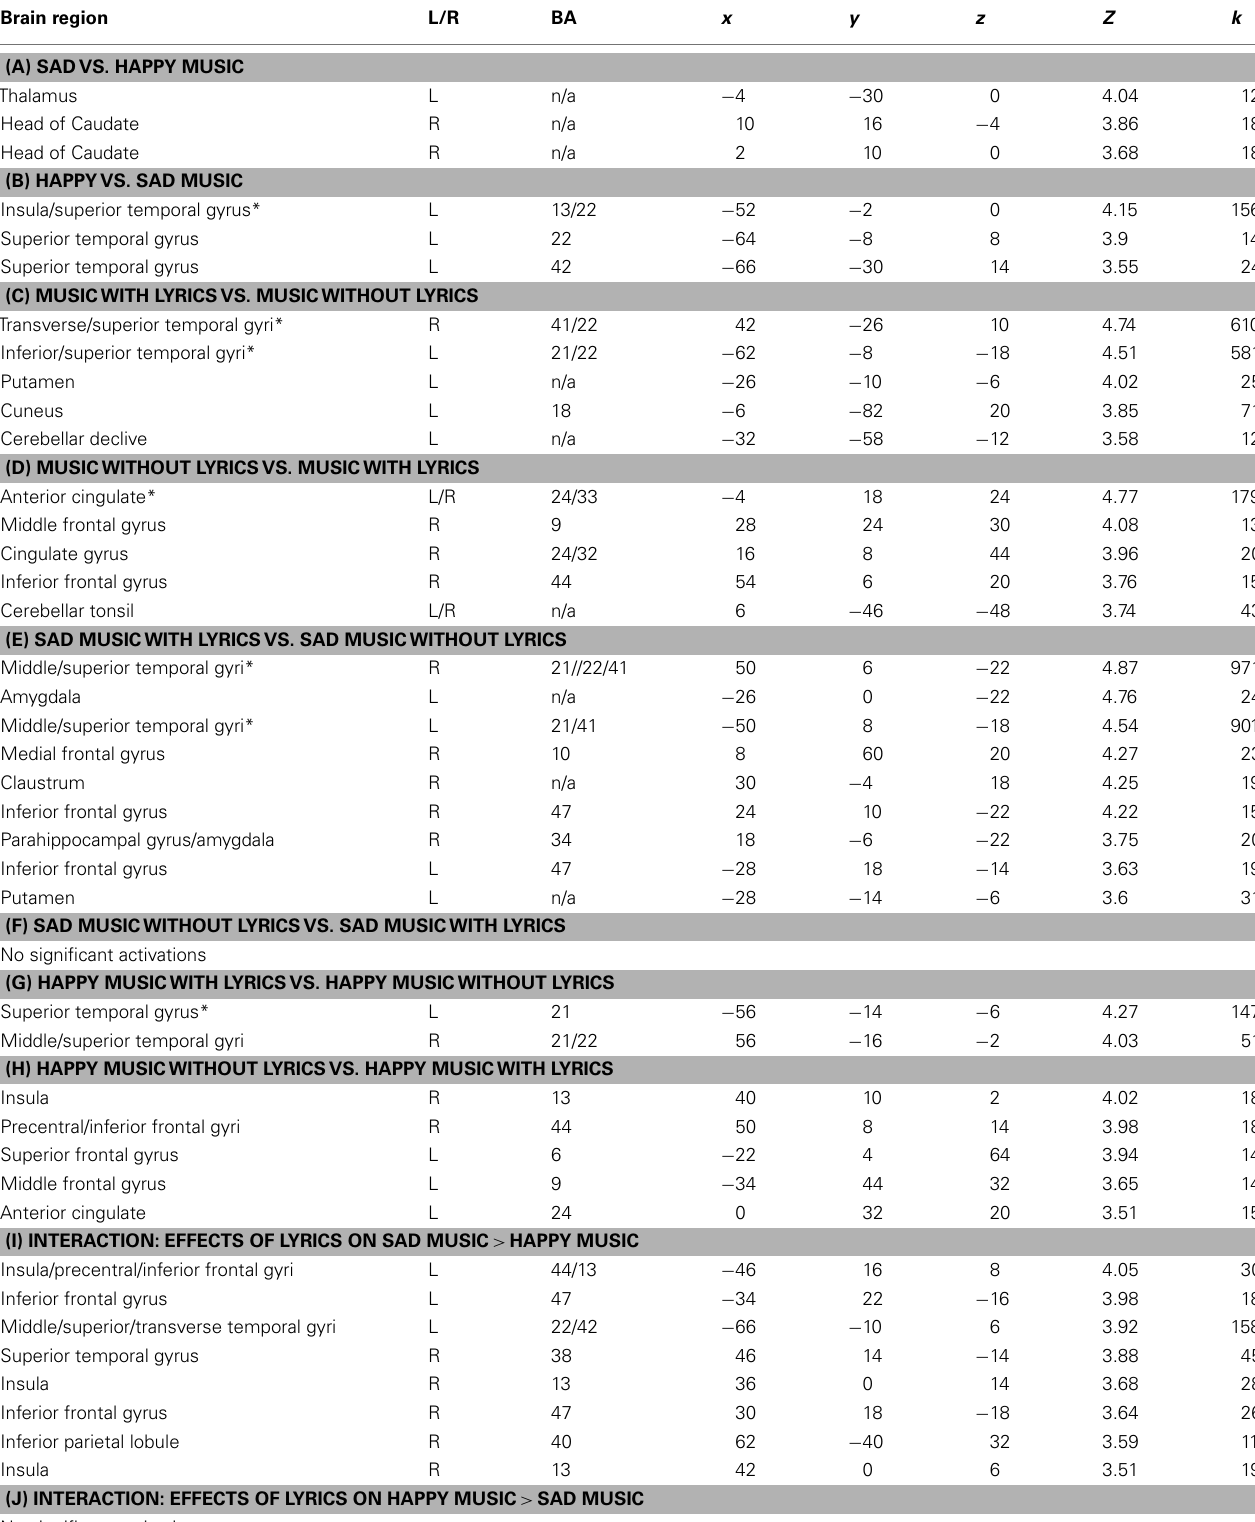
Table 1 |Anatomical labels based on center of mass, MNI-coordinates, and Z -score of global maxima within clusters of significant activations ( p < 0.001; Z > 3.5; k > 10 with k standing for number of voxels: distance between clusters > 8mm). Brain